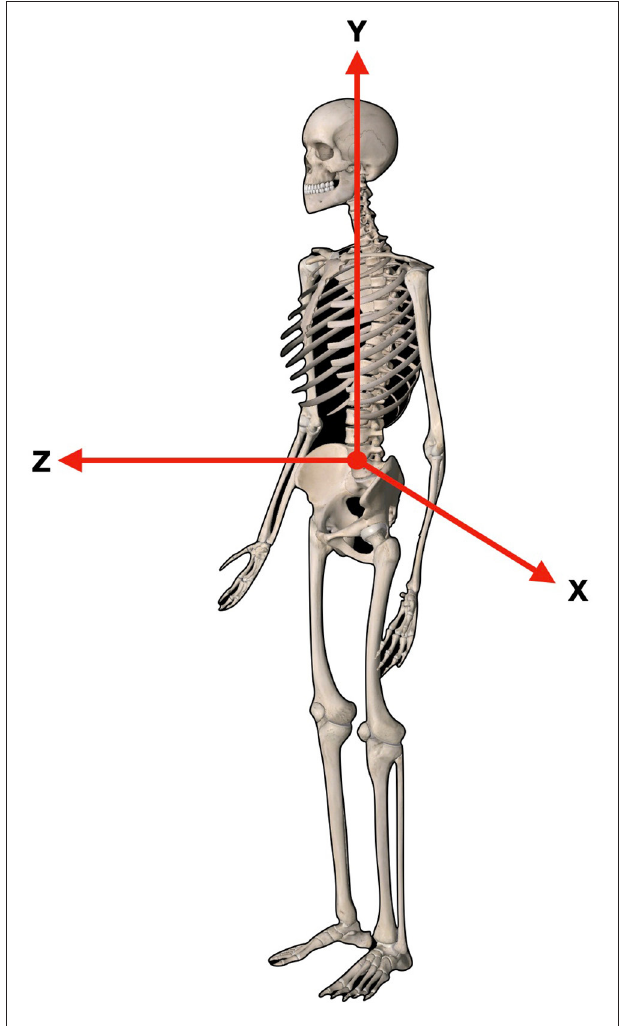
FIGURE 1 | Y -axis represents the frontal axis, superior/inferior. Z -axis represents the sagittal axis, anterior/posterior. X -axis represents the transverse axis right to